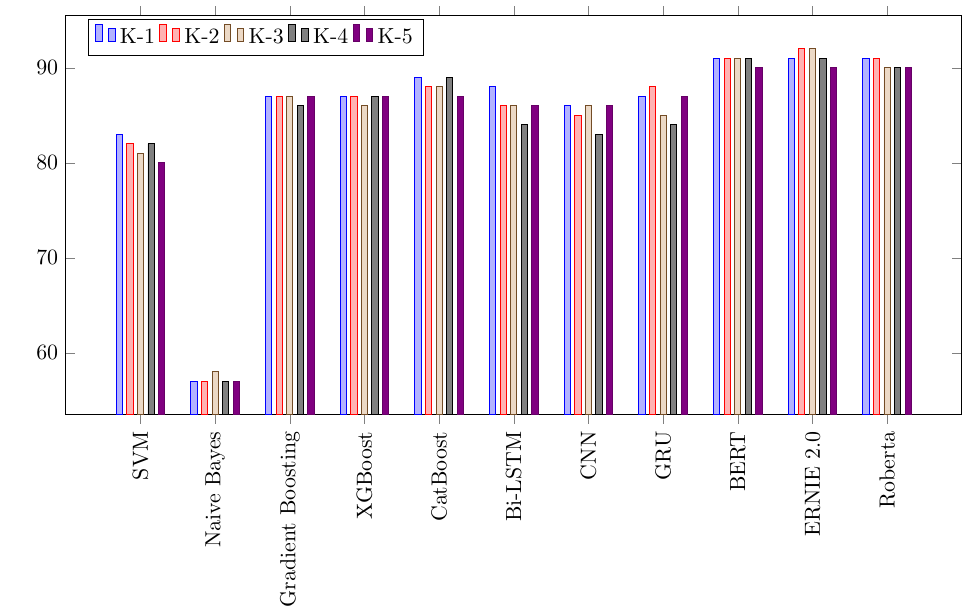
Figure 10. ROC/AUC results across k -fold